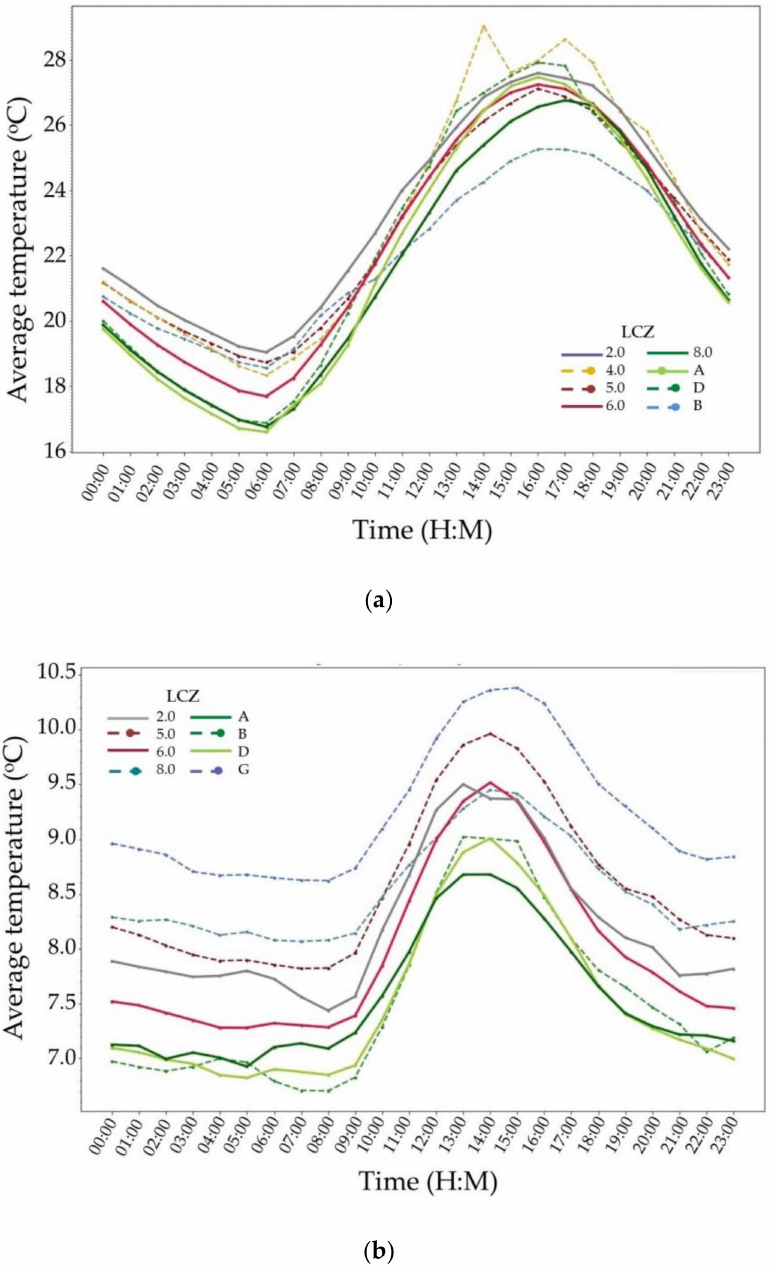
Figure 7. The mean diurnal temperature cycle for each LCZ (mean temperature of every station in the relevant LCZ at that hour) for July ( a ) and December ( b ). The number of stations in each LCZ is the same as that indicated in Figure 5 for July and Figure 6 for December. LCZs 2, 6, A, and D are highlighted to emphasise differences between LCZs with different forms, and that is common in